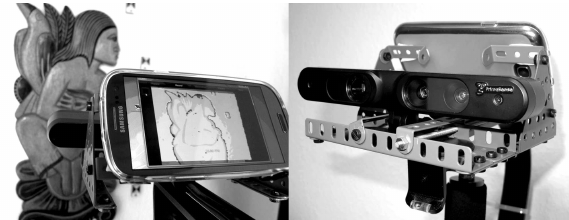
Figure 4: Primesene Carmine 1.09 mounted on a steady cam together with a smartphone as a control unit